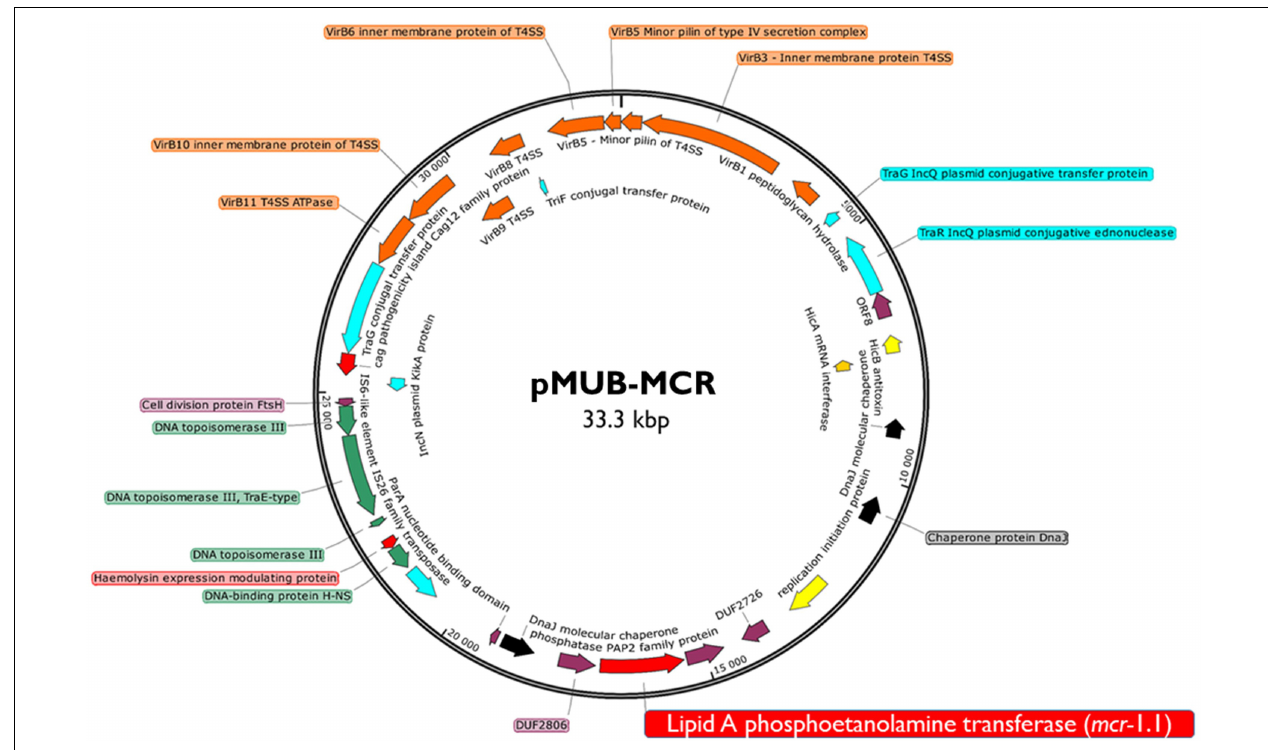
FIGURE 1 | Genetic structure of mcr -1.1 harboring IncX4 plasmid. Figure represents a RAST (Rapid Annotation using Subsystem Technology)-annotated plasmid produced by the E. coli MIN6 strain. Arrows on the diagram represents annotated functional genes present within the structure of 33.3 kb IncX4